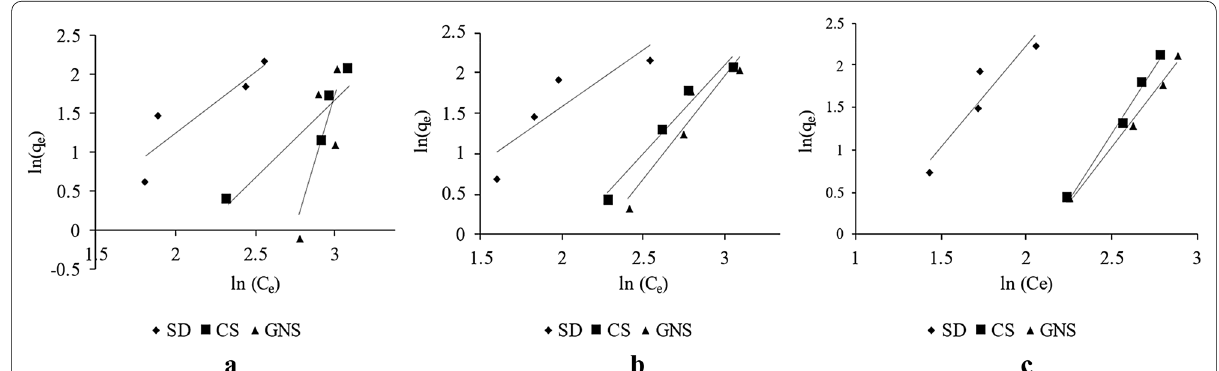
Fig. 6 a Freundlich isotherm at 30 °C for SD, CS and GNS; b Freundlich isotherm at 45 °C for SD, CS and GNS; c Freundlich isotherm at 60 °C for SD, CS and GNS